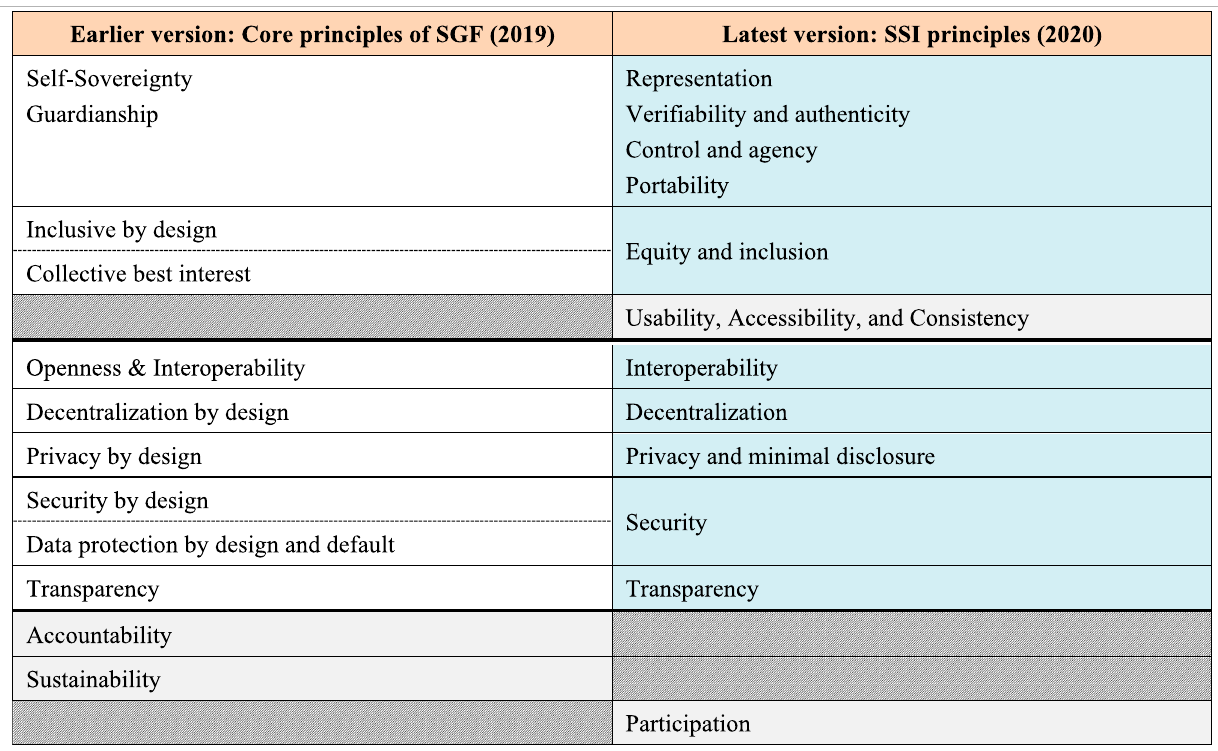
TABLE 3 | Self-sovereign identity core